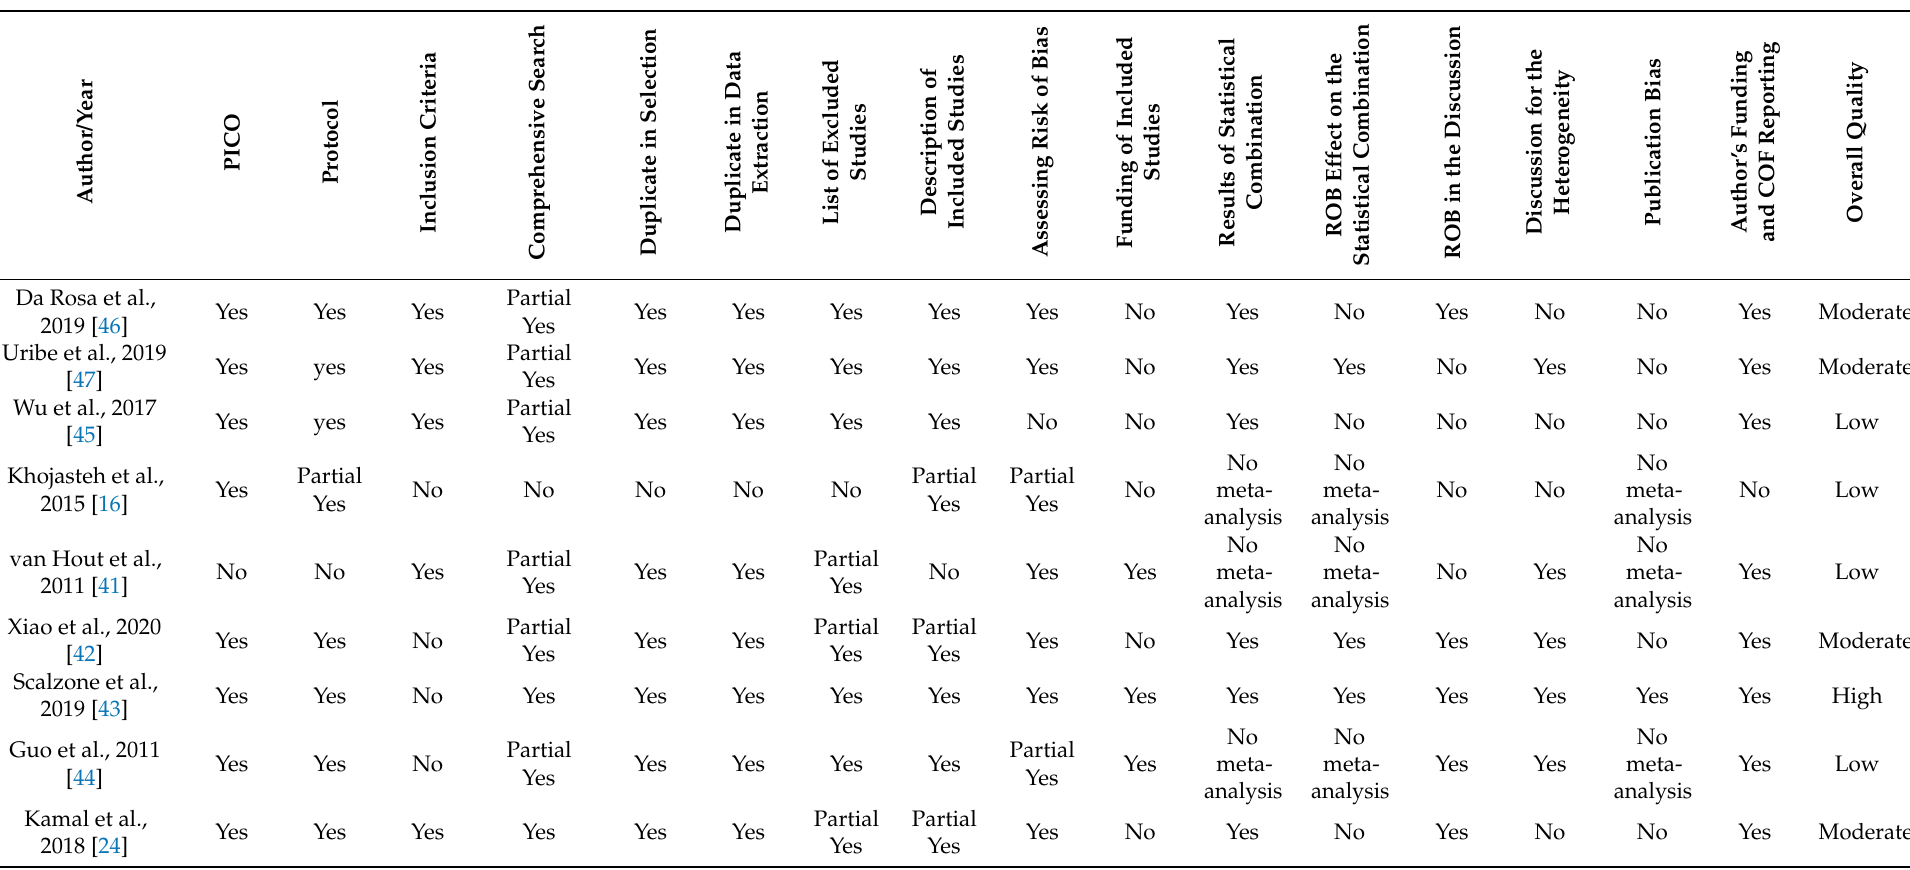
Table 3. Quality assessment of the included reviews, using the AMSTAR2